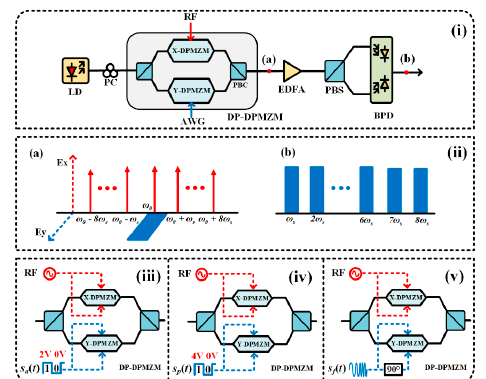
Figure 1. ( i ). Schematic diagram of proposed signals generators. LD, laser diode; PC, polarization controller; DP-DPMZM, dual-polarization dual-parallel Mach–Zehnder modulator; RF, radio fre- quency; AWG, arbitrary waveform generator; PBS, polarization beam splitter; PBC, polarization beam combiner; EDFA, erbium-doped fiber amplifier; BPD, balanced photodetector. ( ii ). Spectra at different points in subfigure ( i ). ( iii ). Amplitude modulation. ( iv ). Phase modulation. ( v ). Frequency modulation. In the X-DPMZM, the direct current (DC) biases of MZM1, MZM2, and the main MZM are, respectively, set at maximum transmission point (MATP), minimum transmis- sion point (MITP), and quadrature transmission point (QTP). Assuming that the optical wave from LD is